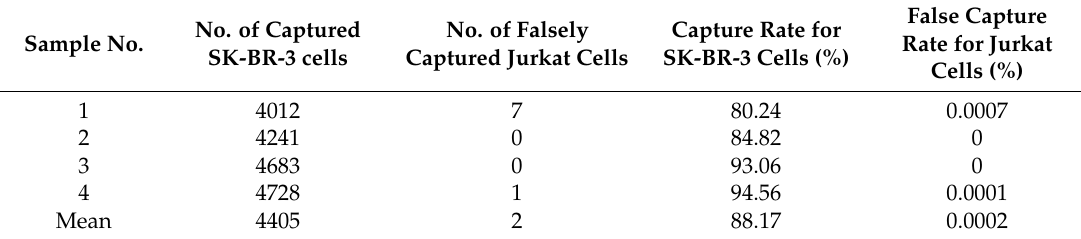
Table 1. A summary of the cell spiking test: In each sample, 5 × 10 3 SK-BR-3 breast cancer cells were mixed with 10 6 Jurkat cells in 200 µ L Dulbecco's phosphate-buffered saline (DPBS) and subjected to